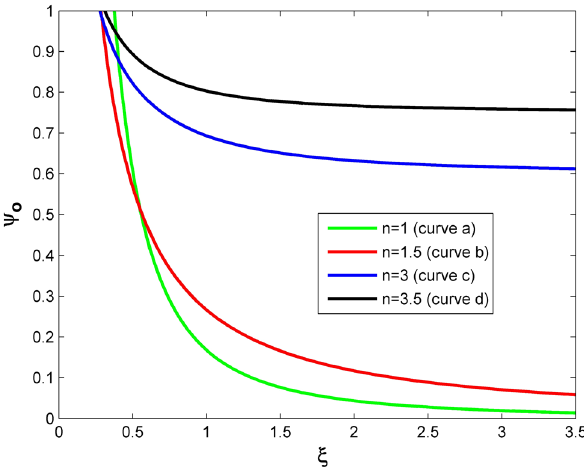
Fig. 2 Graphs between ξ and ψ o